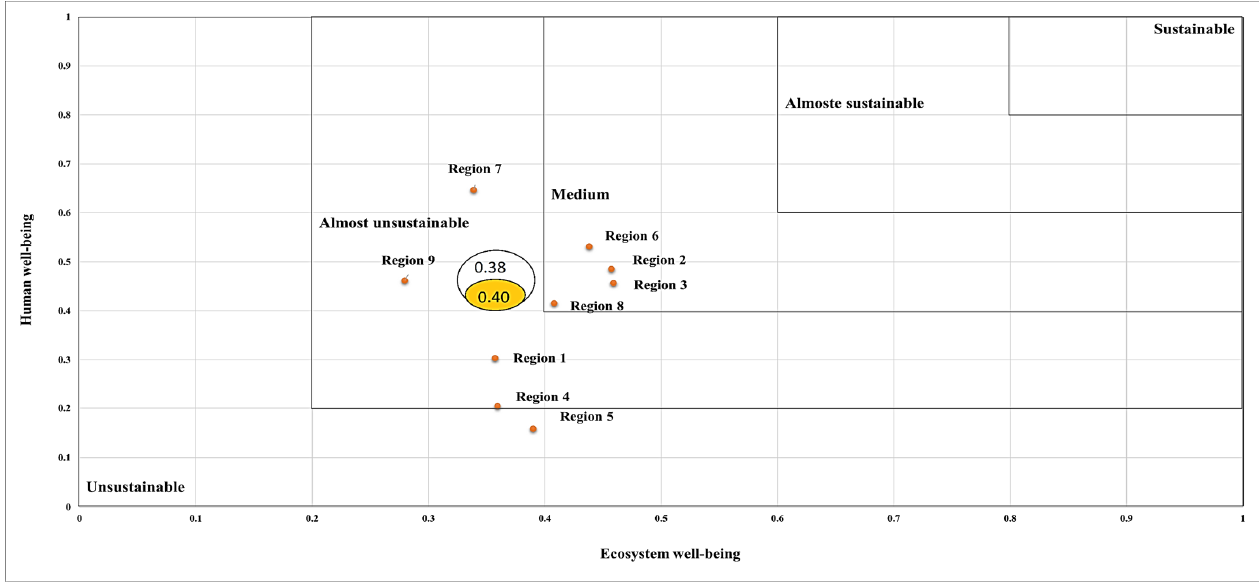
18 of 25 Figure 10. Cultural evaluation of the 9 regions: H 1,2,1 (Cultural places = 48–51), H 1,2,2 (Religious places = 52–53). 3.2. Assessment of Urban Sustainability in District 4 Based on Two Broad Dimensions 3.2.1. Sustainability of Ecosystem Well-Being The ecosystem well-being in District 4 was considered based on the results of evalu- ating the environmental sustainability dimension, as shown in Figure 11. In fact, none of the regions are in a satisfactory condition based on the Prescott-Allen ranking already presented in Table 4, and urgent arrangements are necessary to improve the ecosystem in